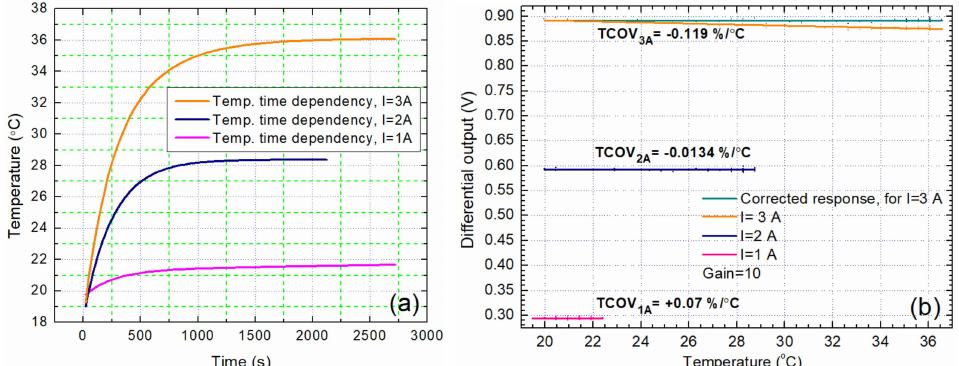
Figure 16. ( a ) The time dependency of the sensors temperature for I = 1 A, 2 A, and 3 A; ( b ) the thermal drift of the di ff erential output. The temperature variation is caused by the Joule heating of the conductive